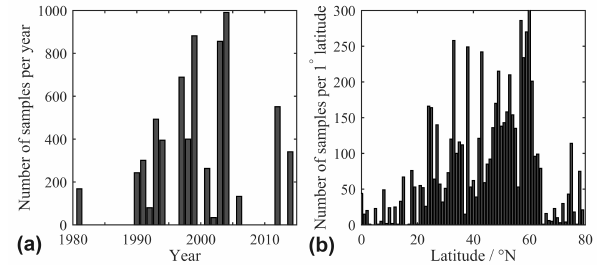
Figure 2. The temporal distribution of the presented dataset ordered by year (left panel) and the sum of all samples at each latitudinal degree (right